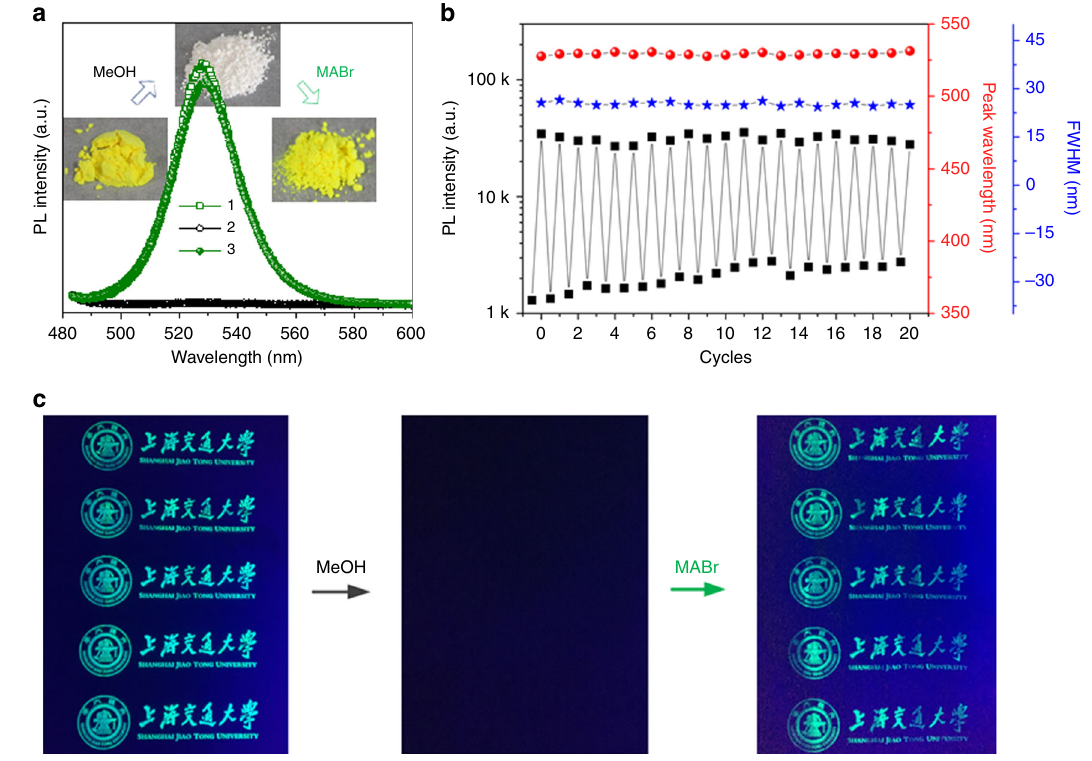
Fig. 4 The reversible on/off switching property of perovskite NCs-MOF platform. a Sequential optical images and PL emission spectra of MAPbBr 3 NCs@Pb-MOF after one cycles of impregnation-recovery process. 1, 2, and 3 represent the original, impregnated, and recovered powder sample of MAPbBr 3 NCs@Pb-MOF, respectively. b PL intensity, peak wavelength, and FWHM of MAPbBr 3 NCs@Pb-MOF in the impregnation-recovery cycles as a function of cycle number. c Reversible fl uorescence switching of the MAPbBr 3 NCs@Pb-MOF pattern in one encryption – decryption cycle